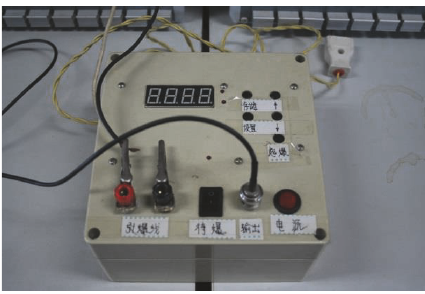
Figure 7: TNT charge.